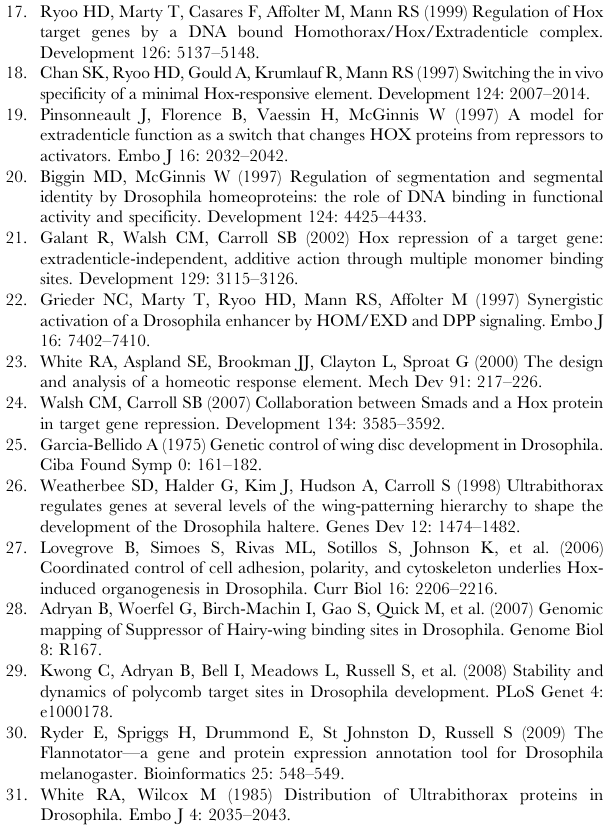
Table S3 Ubx-regulated genes identified by non-microarray approaches. XLS) Data Sets S1 Windowed enrichment ratios (log2Ratios) for Ubx ChIP on haltere imaginal disc chromatin (.sgr